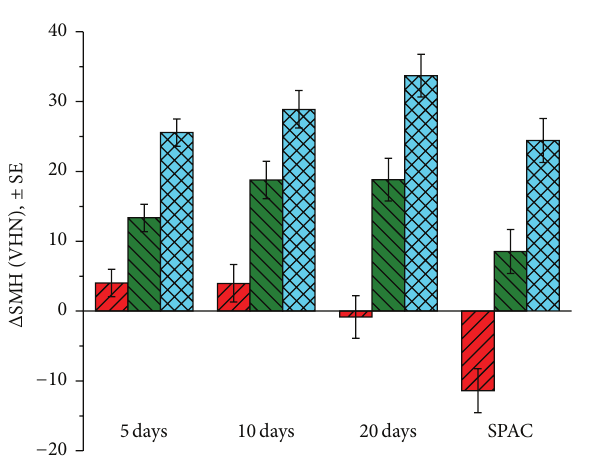
Figure 4: Mean fluoride content ( 𝑛 = 18 specimens) after 20 days of the pH cycling